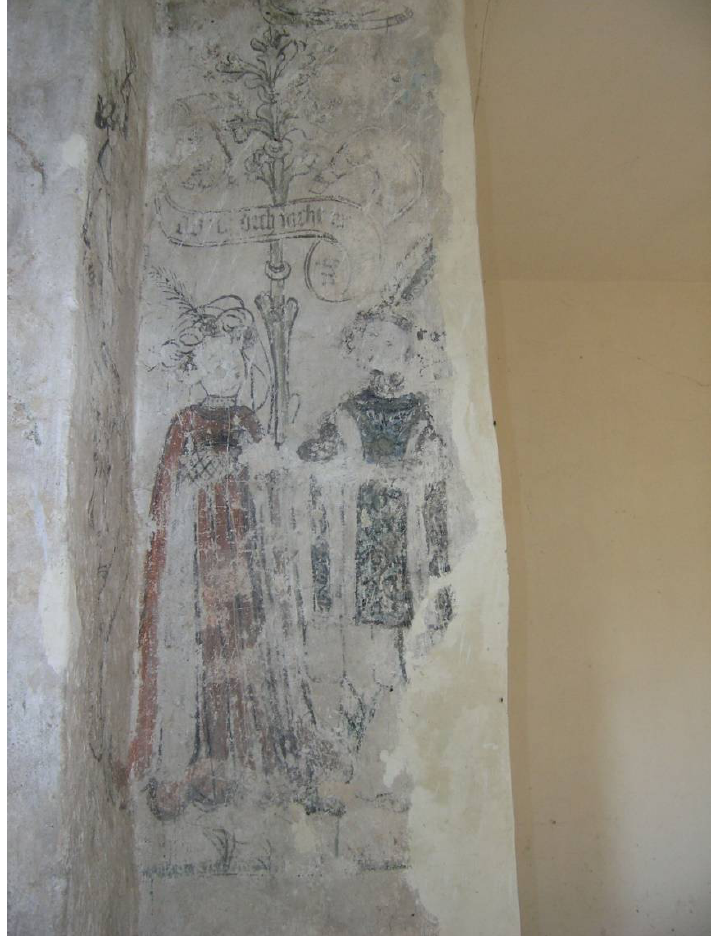
Figure 29. Witków, tower. Wedding scene. Around 1450. Photo by Dagmara Adamska, the author’s own work.